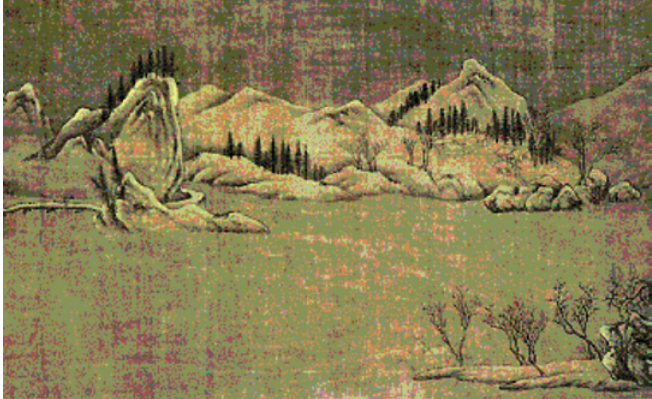
Fig. 3. Wang Wei. Clearing after Snow